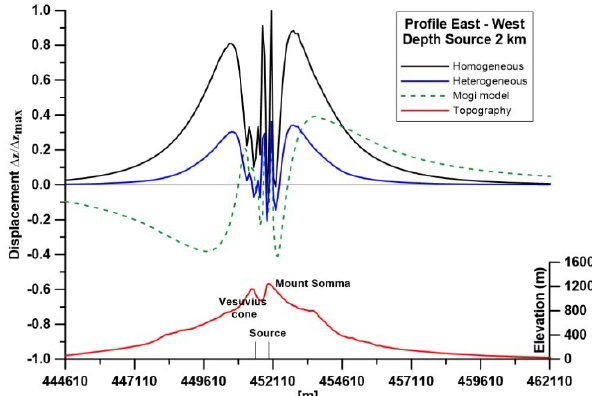
Figure 6. Normalized vertical displacements for homogeneous, het- erogeneous cases and Mogi model, which does not take into account the topography, along East-West